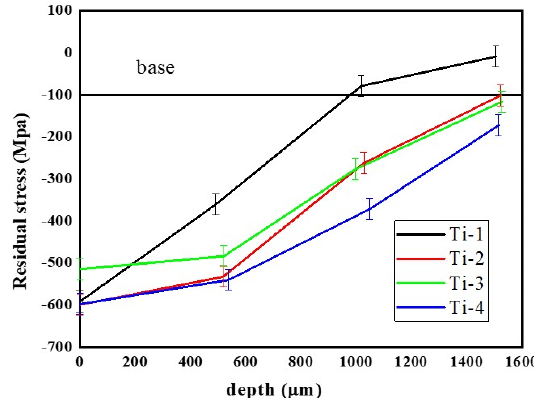
Figure 7. Residual stress of TC6 titanium alloy samples.